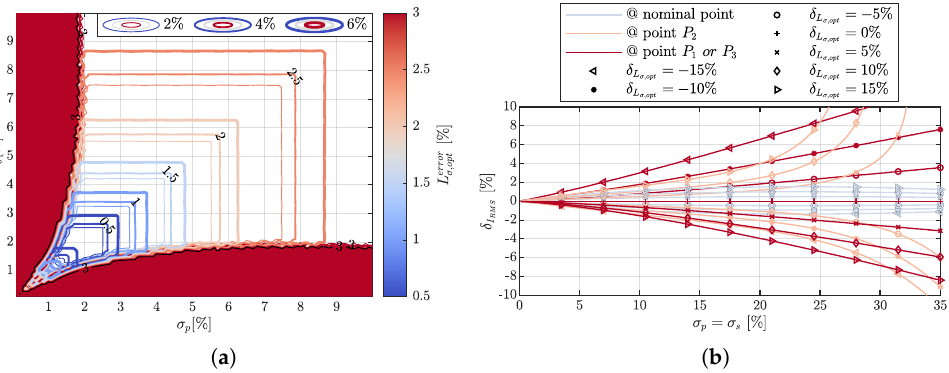
Figure 11. ( a ) L error σ ,opt of the YY-connected 3 φ MFT for different percentages of total transition times per fundamental period (2 f sw T transition ). In the red-colored region, the error is higher than 3%. ( b ) The deviation in the RMS value of the phase current for a 3 φ YY-connected DAB at the nominal power for different percentages of deviation from the desired leakage inductance obtained from